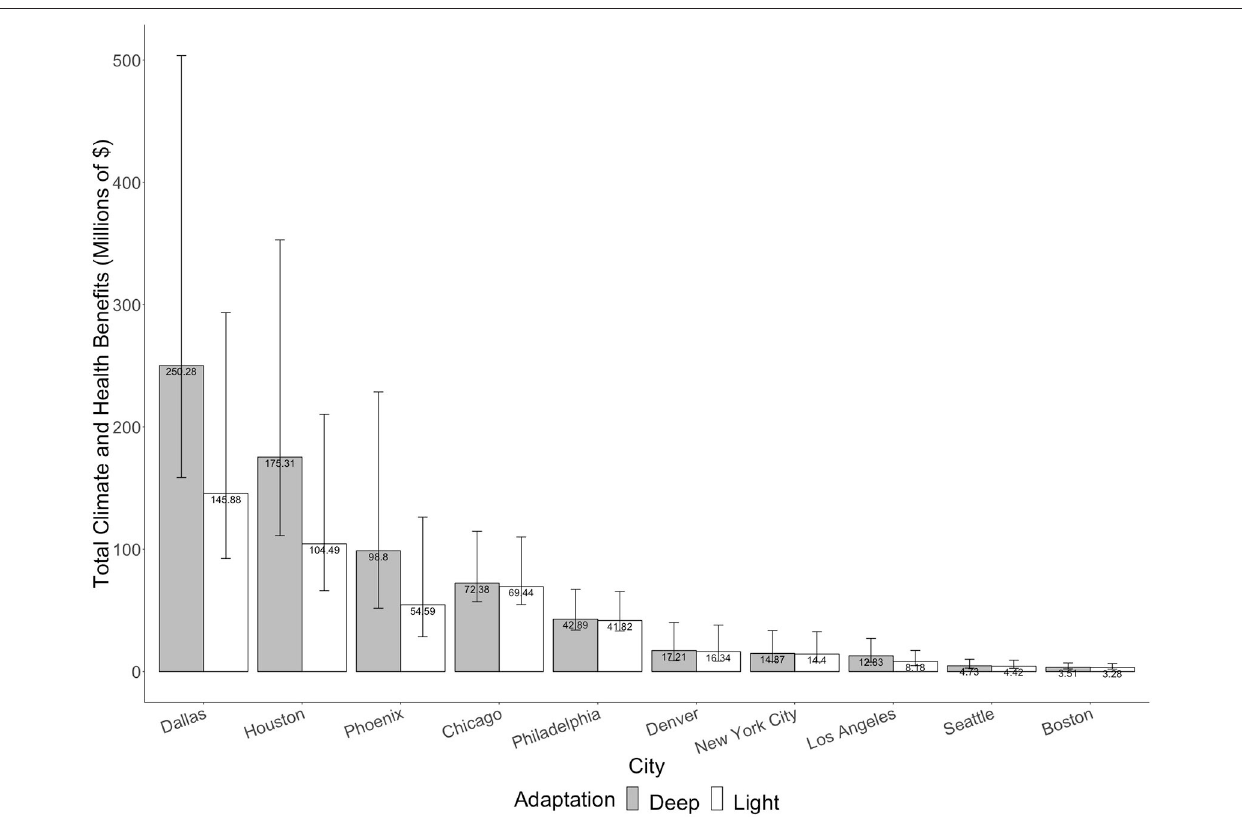
Frontiers in Sustainable Cities | www.frontiersin.org